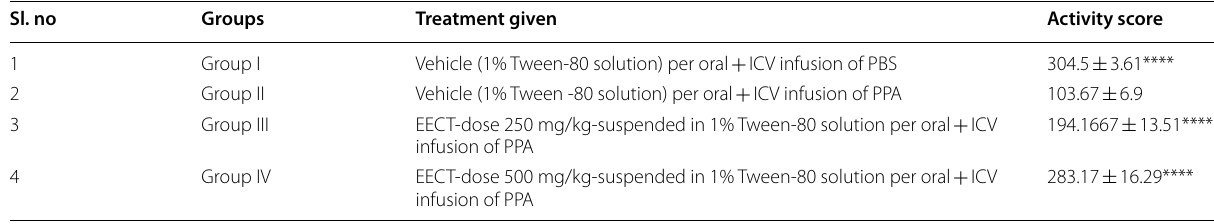
Values are represented in Mean SD (Standard deviation), n 6 (6 rats in each group) ± = Comparison: Group II vs Group I, Group II vs Group III, and Group II vs Group IV ns, non significant **** p < 0.0001. Upon statistical analysis, on comparison with Group II we got highly significant results with p -value (probability value) less than 0.0001, indicating the effectiveness of the extract